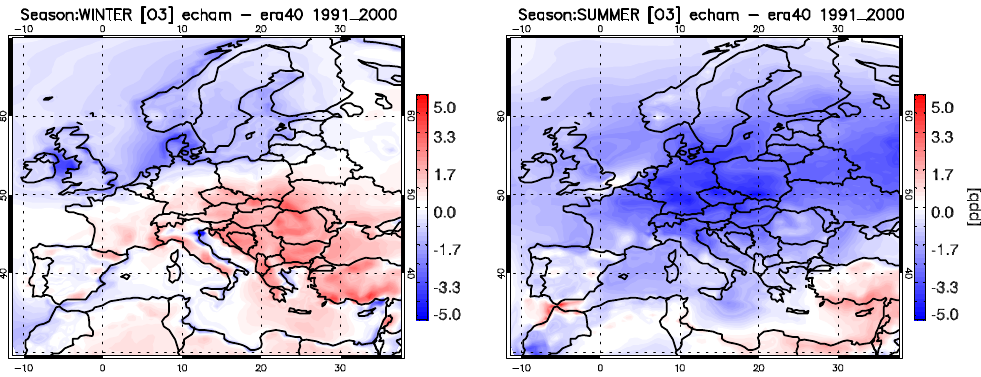
Figure 3. Differences in simulated average surface O3 fields between the ECHAM and ERA Fig. 3. Differences in simulated average surface O 3 fields between the ECHAM and ERA simulations for winter (left) and summer (right) representative of the 90s. simulations for winter (left) and summer (right) representative of the 90s.